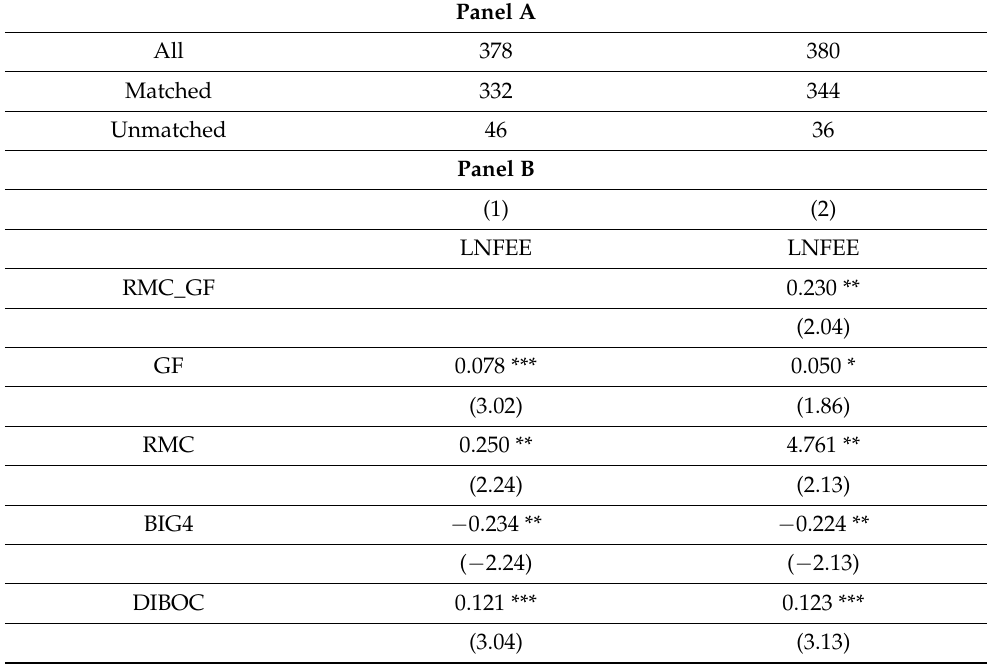
Table 9. Coarsened exact